Question: Which visualization type does this figure use?
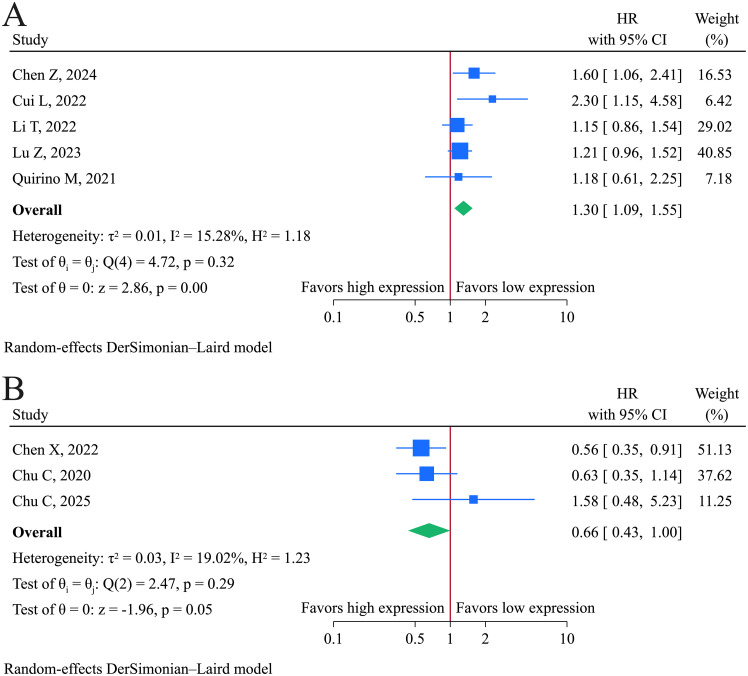
Answer: forest